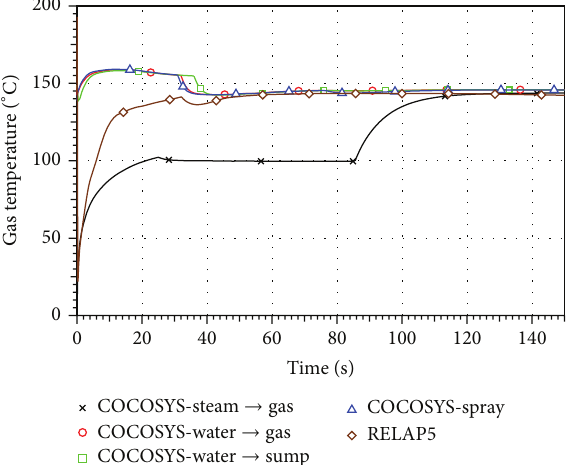
Figure 5: Coolant release options: pressure in the PV. Figure 6: Coolant release options: gas temperature in